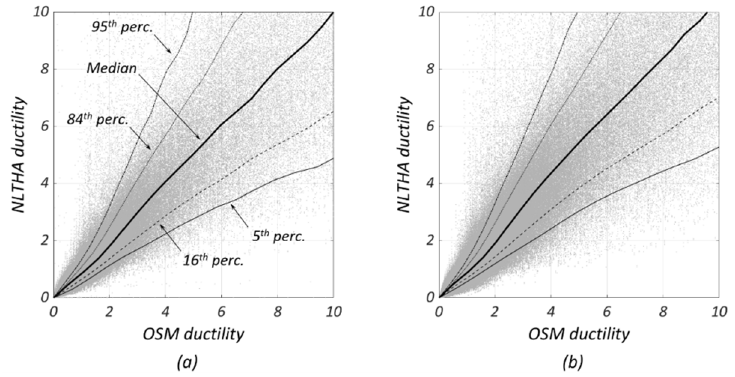
Figure 12. Comparison between ductility demands from the proposed optimal stiffness method (OSM) and from NLTHA: ( a ) Suite 1-A, and ( b ) Suite 1-B. Good agreement was also observed between the predicted and the NLTHA-derived median 𝐶 (cid:3019) ‒ 𝑅 ‒ 𝑇 and 𝜇 (cid:3019) ‒ 𝑅 ‒ 𝑇 spectra, as shown in Figure 13. It is noteworthy that, for periods 𝑇 (cid:3408) 0.3 s , the predicted curves approach those obtained by NLTHA, as opposed to the equivalent linearization procedures by NPR 9998-18 [18] and FEMA 440 [22], which deviate significantly.